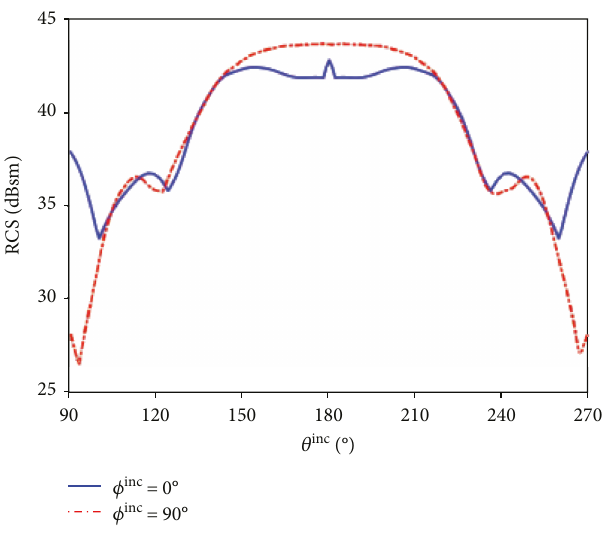
Figure 8: Value of the maximum RCS ( α = 0 ).